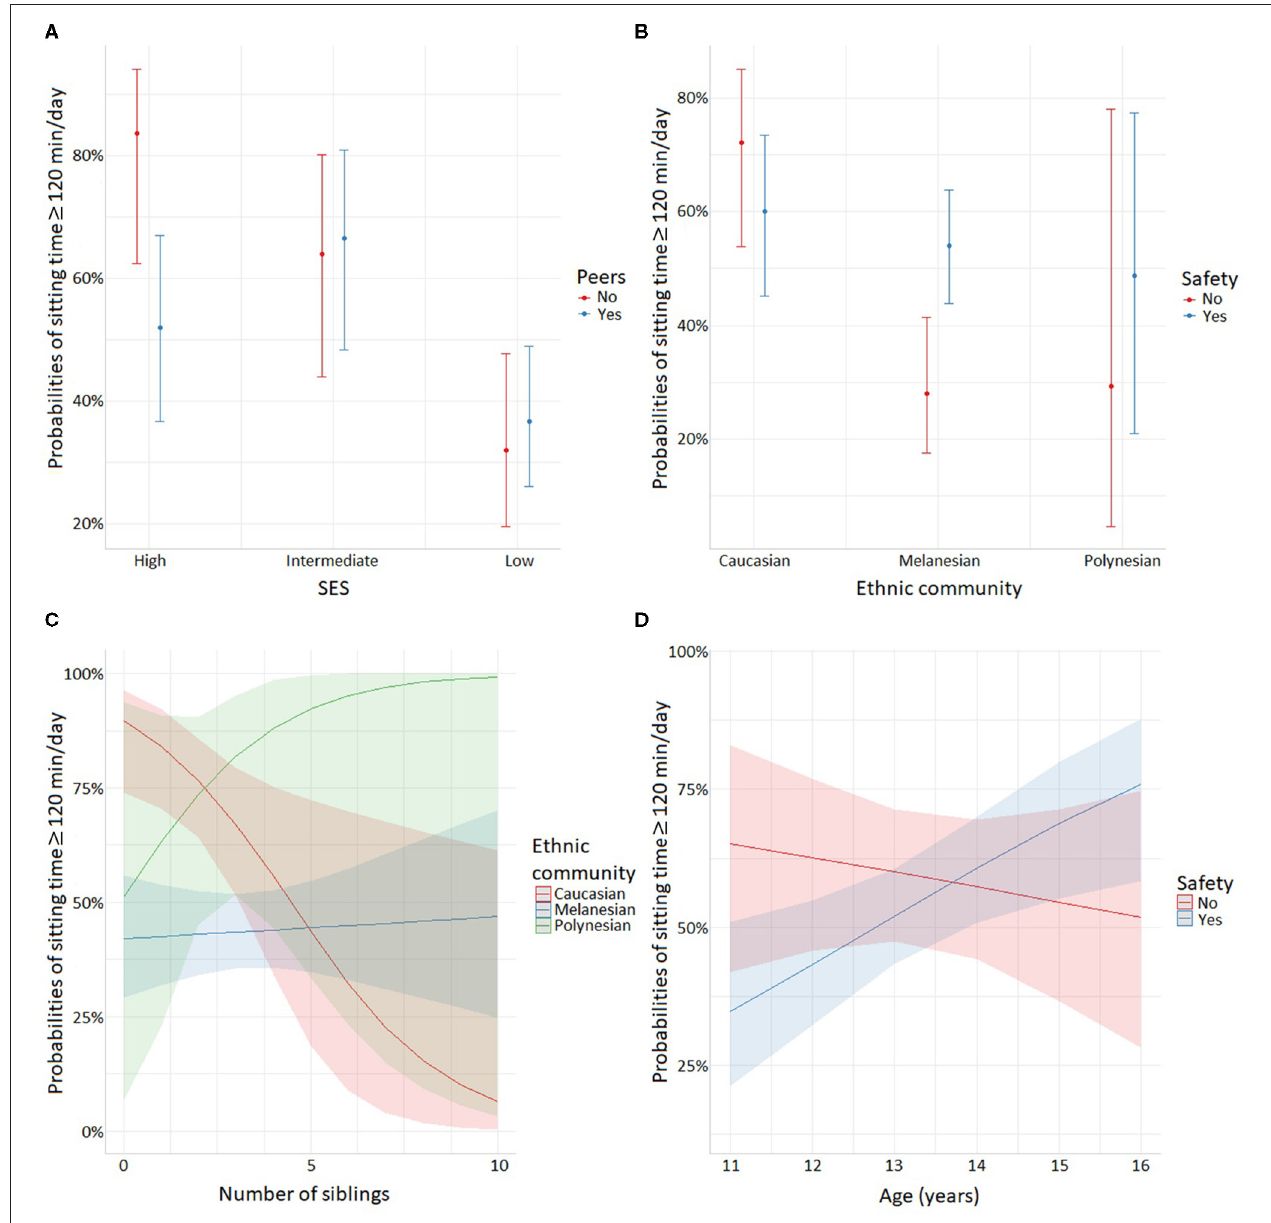
FIGURE 6 | Significant interactions for out-of-school sitting time: (A) interactions between SES and importance of practicing PA with peers in female adolescents, (B) interactions between ethnic community and safety in female adolescents, (C) interactions between ethnic community and siblings in male adolescents, (D) interactions between age and safety in male